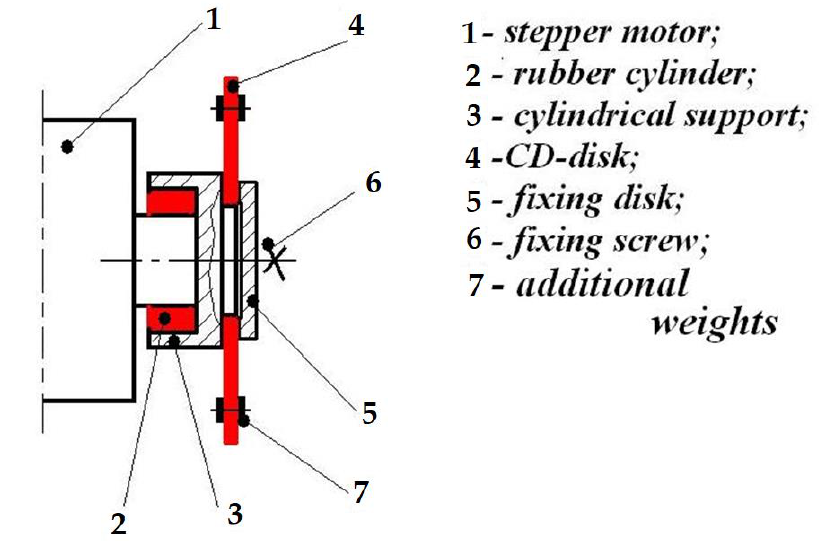
Figure 8. Sketch of the testbed.